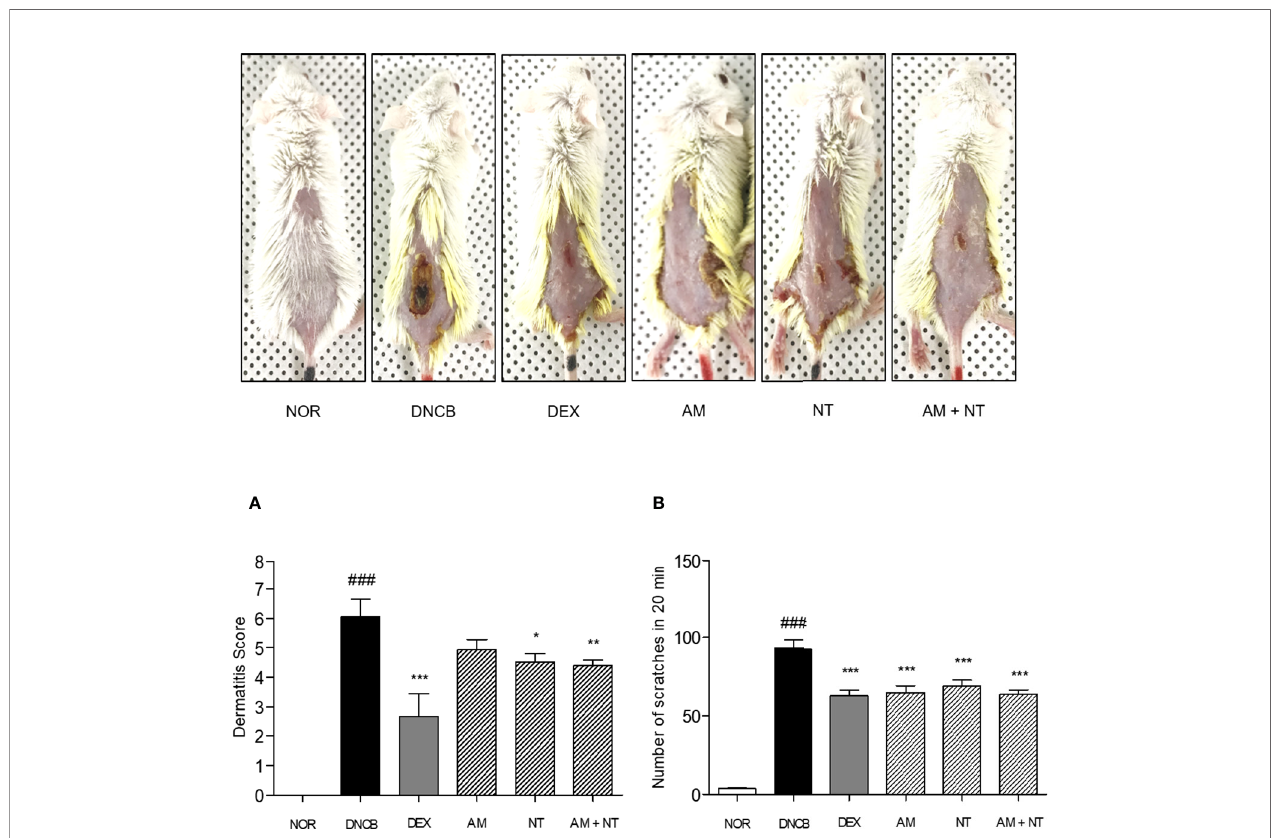
FIGURE 1 | Effects of AM, NT, and a mixture of AM and NT on skin dermatitis scores (A) and scratching behaviors (B) with allergic contact dermatitis skin lesions. The scratching behavior was evaluated 1 h after the last DNCB application on the day before sacri fi ce. Data were presented as means ± S.E.M (n = 5). ### p < 0.001 vs. NOR; * p < 0.05, ** p < 0.01, and *** p < 0.001 vs.